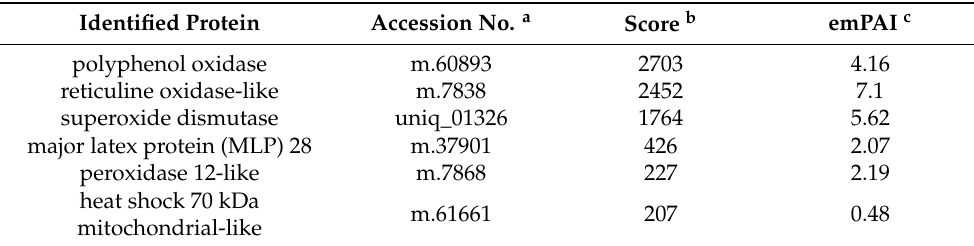
Table 2. Selected proteins identified by mass spectrometry in the C. majus latex protein fraction. The table shows the results with score above 200 and arranged according to the decreasing